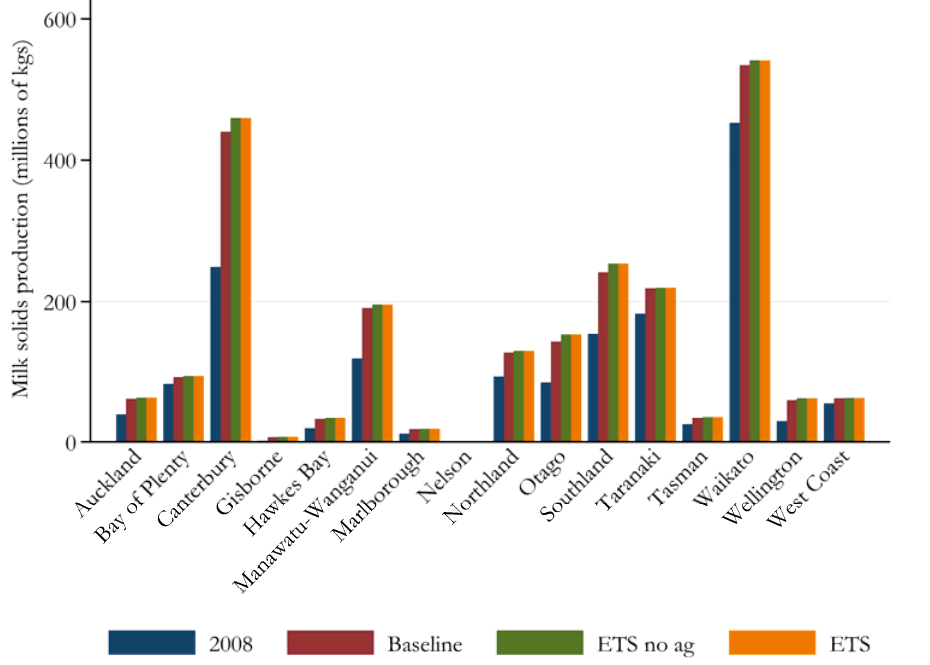
Figure 5. Milk solids production by region in 2008 and in 2030 policy scenarios. Blue bars show LURNZ estimates of the total output by regional council in 2008. Red, green and orange bars show, respectively, projected output in 2030 under the baseline, with an ETS that does not include agriculture, and under the full ETS. Details on output projections are in Timar